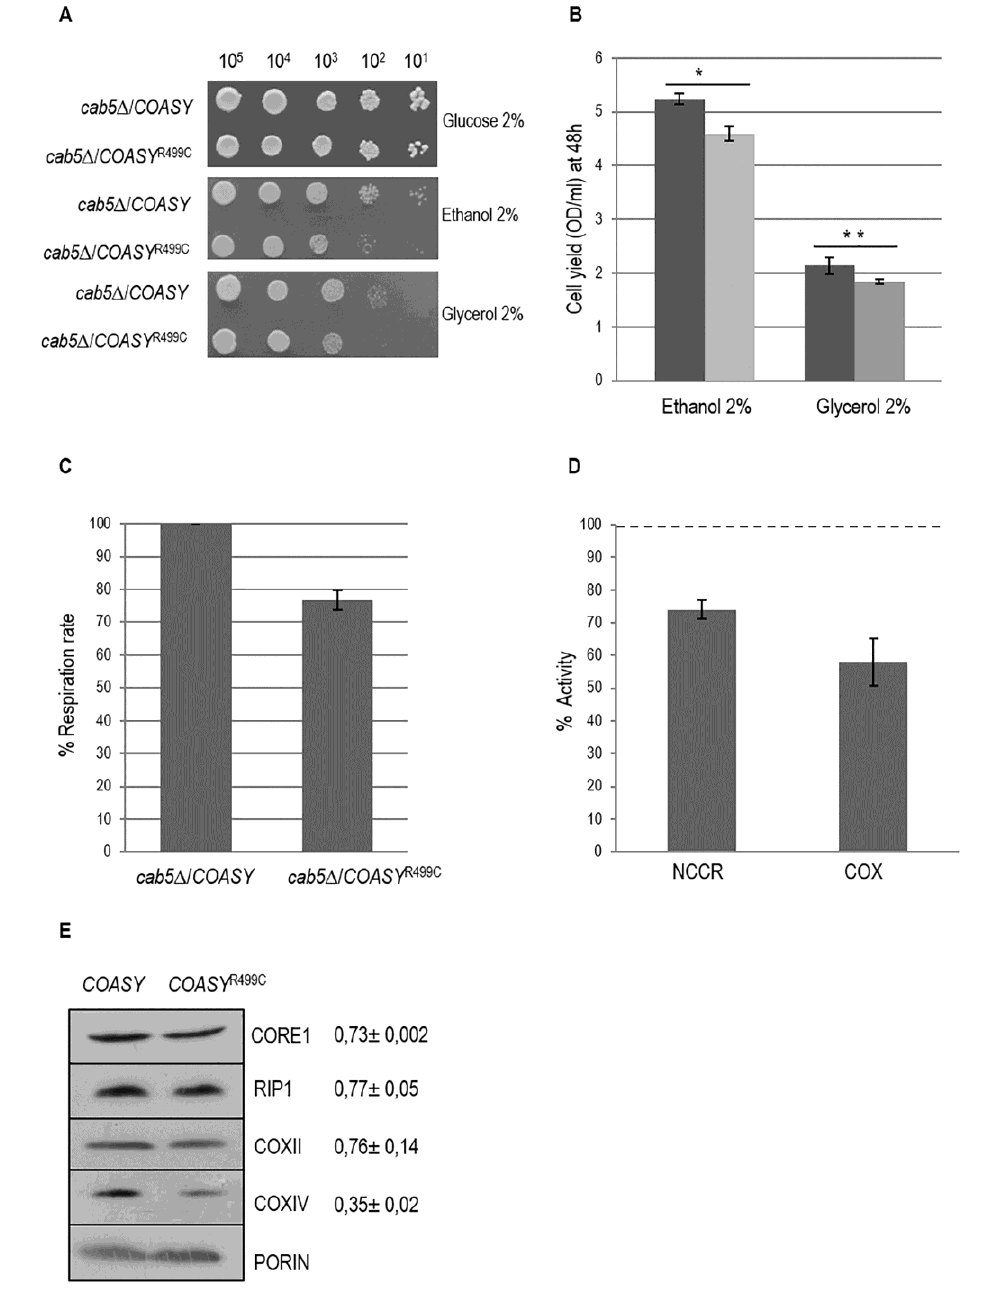
FIGURE 2: Characterization of mitochondrial functions. (A) Oxidative growth phenotype. The strain W303-1B cab5 Δ was transformed with a pYEX-BX plasmid carrying the wild-type COASY or the mutant allele COASY R499C . Equal amounts of serial dilutions of cells from exponentially grown cultures (10 5 , 10 4 , 10 3 , 10 2 , 10 1 ) were spotted onto mineral medium (40) plus 2% glucose, 2% ethanol or 2% glycerol without panto- thenate. The growth was scored after 5 days of incubation at 28°C. (B) Cell yield. Cell yield was calculated by growing cells on liquid medium containing ethanol or glycerol and measuring the optical density at 600 nm after 48h of growth ( COASY black columns and COASY R499C grey columns). Values are mean of three independent experiments. * P < 0.05; **P < 0.01 (unpaired two-tailed t-test). (C) Oxygen consumption rates. Respiration was measured in cells grown in mineral medium (40) plus 0.2% glucose and 2% galactose without pantothenate at 28°C. The values observed for the COASY mutant strain are reported as percentage of the respiration obtained in cells expressing the wild-type COASY gene. (D) NADH-cytochrome c oxidoreductase (NCCR) and cytochrome c oxidase (COX) activities were measured in mitochondria extracted from cells grown exponentially at 28°C in mineral medium (40) plus 0.2% glucose and 2% galactose without pantothenate. The values of the COASY mutant are expressed as percentage of the activities obtained in the wild type strain. (E) Steady state level of cIII and cIV subunits in cells carrying the wild-type COASY and the mutant allele. The filter was incubated with specific antibodies against Core1, Rip1, CoxII, CoxIV and Porin. The signals were normalized according to the control signal (porin) and taken as 1.00 the signal of the cab5 ∆ / COASY (wild-type)